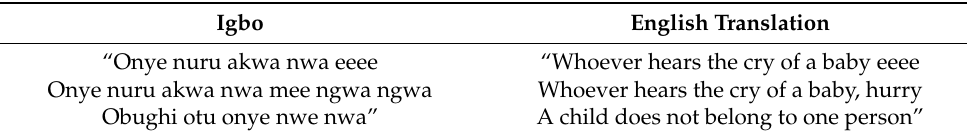
Table 1. Birth Song